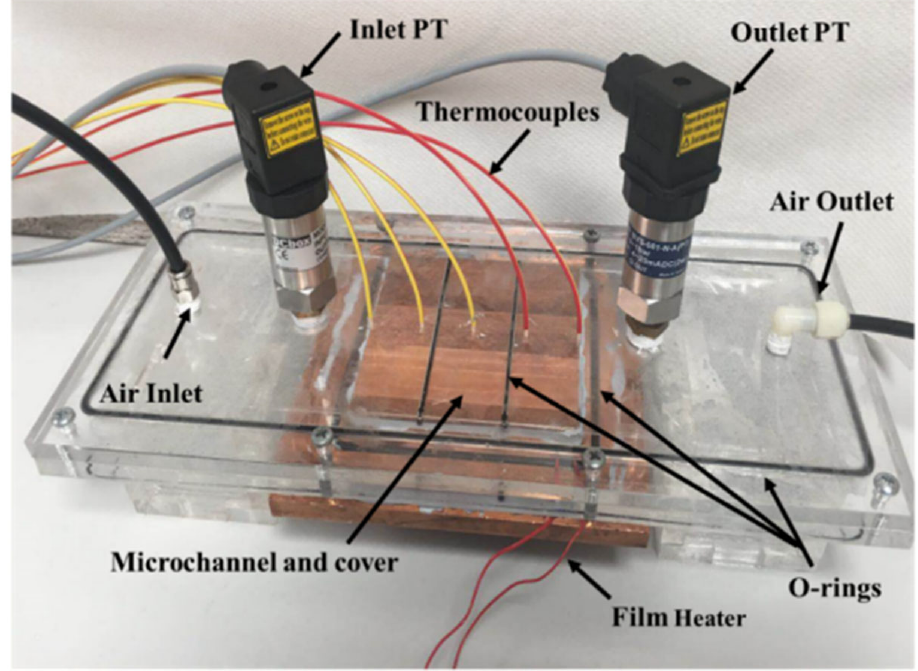
Figure 2. Microchannel solar air receiver test rig equipped with instruments.